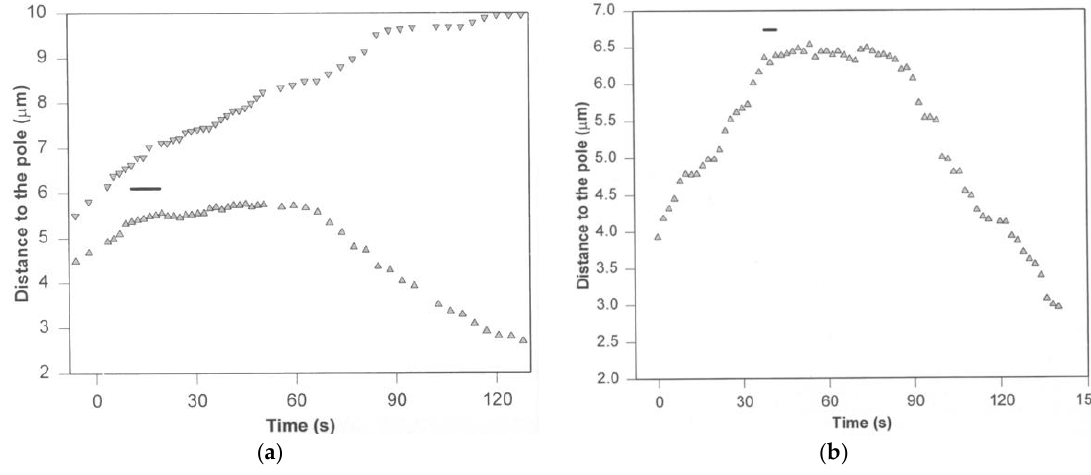
Figure 5. Kinetochores can adopt two distinct states, an active state that generates pole-directed pulling force, and a ‘neutral’ state that remains stationary or passively slips anti-poleward in response to external forces. ( a ) Motions of sister kinetochore regions in a metaphase PtK1 cell before, during ( horizontal bar ) and after micro-surgically separating the sisters. ( b ) Motion of a trailing kinetochore before, during ( horizontal bar ), and after selectively destroying its poleward moving sister kinetochore. In both cases the trailing kinetochore abruptly stops once it is micro-surgically freed from its sister. Then, after a ~20 s delay, it reverses its original directionality and begins to move poleward. These graphs are reprinted from [57], and are displayed under the terms of a Creative Commons License (Attribution-Noncommerical-Share Alike 3.0 Unported license, as described at http://creativecommons.org/licenses/by-nc-sa/3.0/).